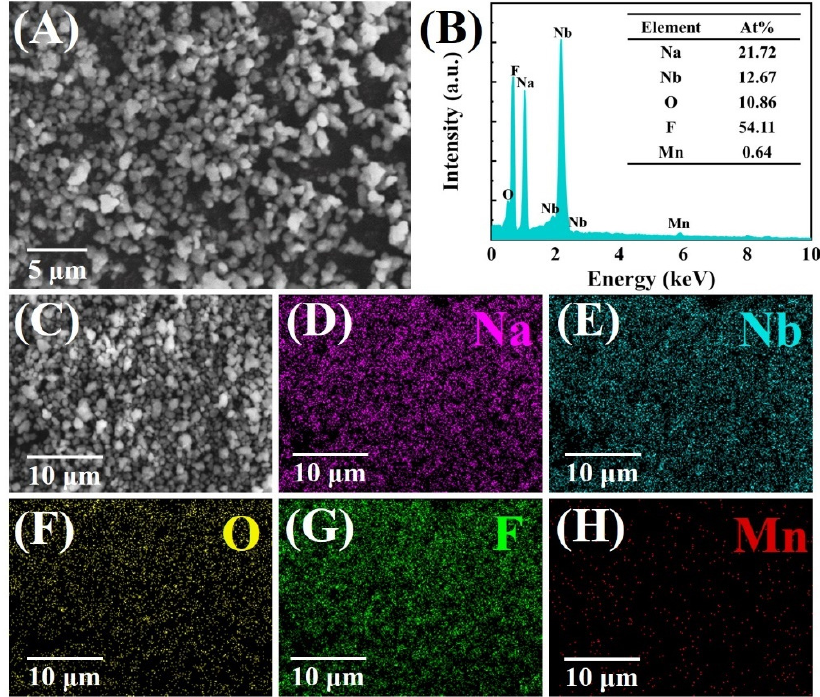
Figure 4. ( A ) SEM image; ( B ) EDS spectrum of NNOF:Mn 4+ phosphor; ( C – H ) element mapping of Na, Nb, O, F and Mn in a selected area of NNOF:Mn 4+ sample.